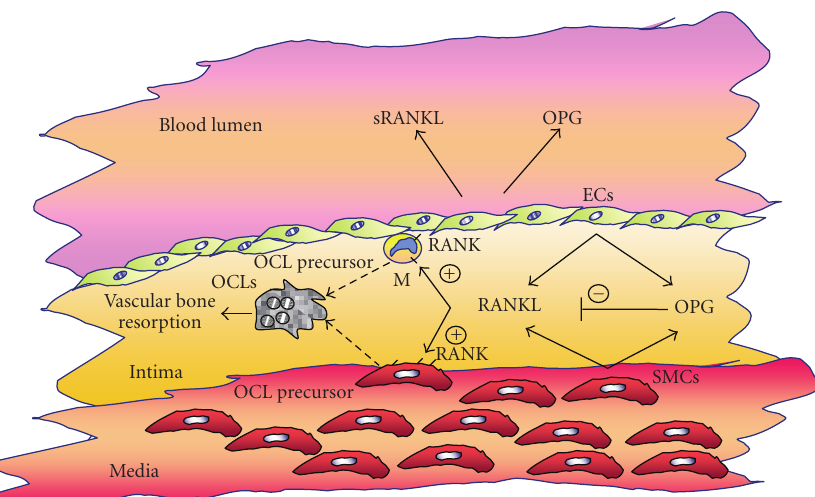
Figure 1: Schematic diagram of potential OCL di ff erentiation in the plaque. Soluble RANKL (sRANKL) and OPG are secreted in the atherosclerotic plaque and in the blood stream mainly by smooth muscle cells (SMCs) and endothelial cells (ECs). sRANKL promotes OCL precursor (mainly monocytes/macrophages (M), dendritic cells, and SMCs) di ff erentiation into OCL cells (as indicated by dotted arrows). OPG neutralizes the action of RANKL. The balance between these two soluble molecules regulates the bone resorption in calcified plaques, which is correlated to plaque